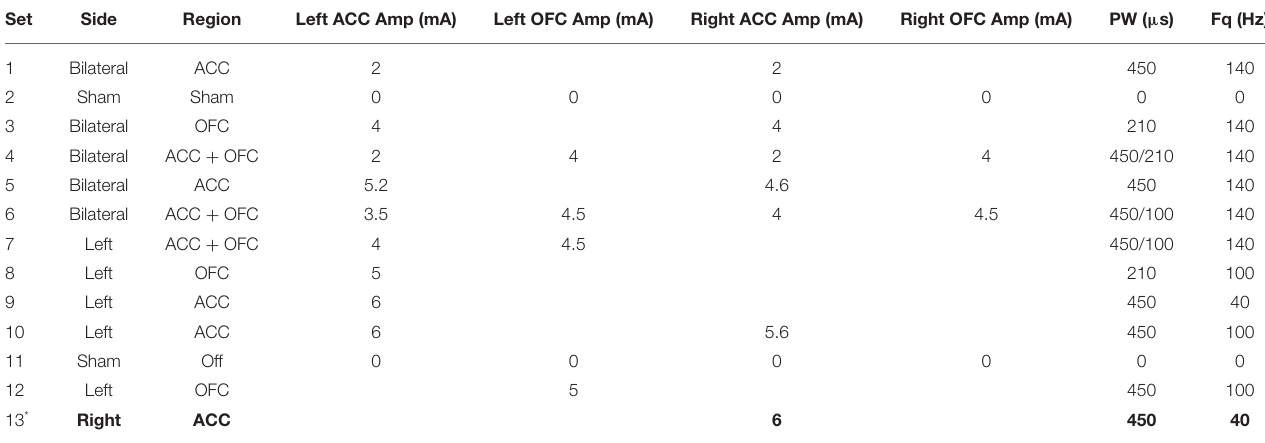
TABLE 1 | Stimulation sets (1–13) programmed onto the patient’s implanted pulse